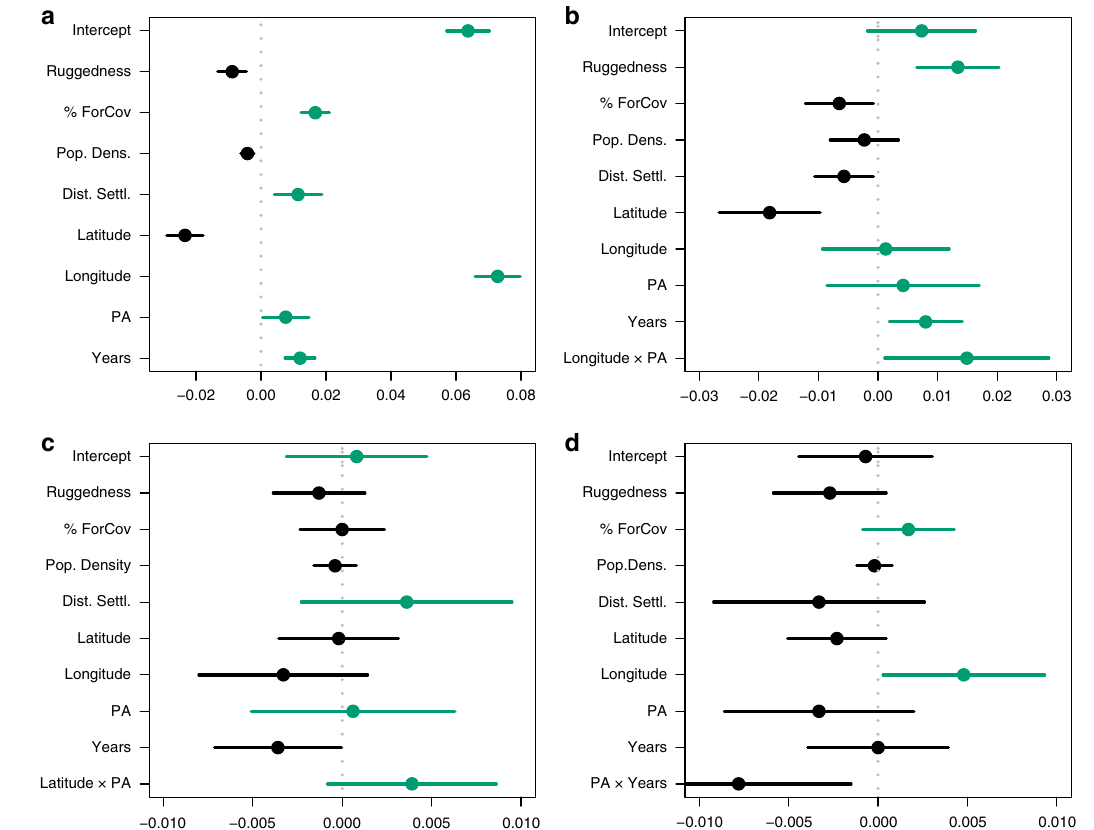
Fig. 3 PA effectiveness estimates derived from hurdle-mixed models. Marginal regression coef fi cients (colored dots) and 95% con fi dence intervals (arrows) from hurdle-mixed models for the impacts of PA (as well as additional matching covariates and interactions) on ( a ) bear, ( b ) lynx, ( c ) wolf, and ( d ) wolverine densities ( n = 1126 unpaired sampling units). (Estimates of covariates having a positive effect on carnivore densities are represented in green and estimates of covariates having a negative effect on densities are represented in